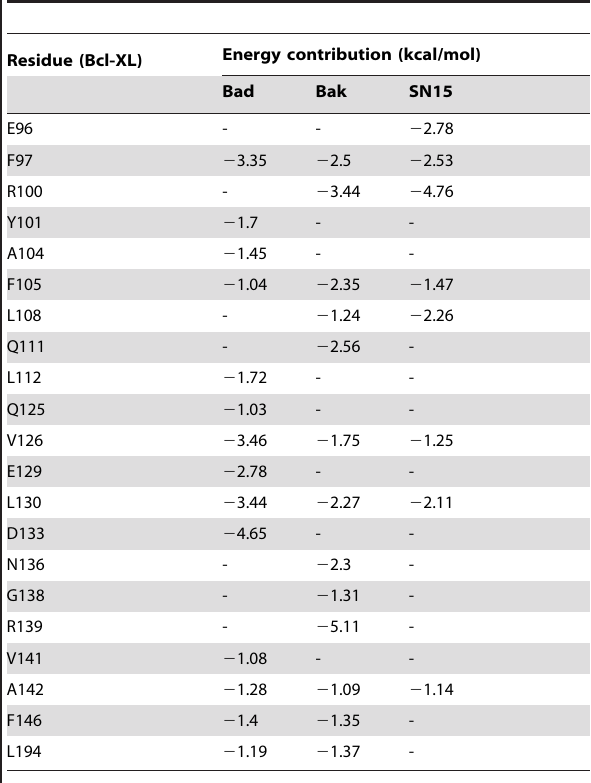
Table 5. Components of binding free energy (in kcal/mol) of Bcl-X L with SN15